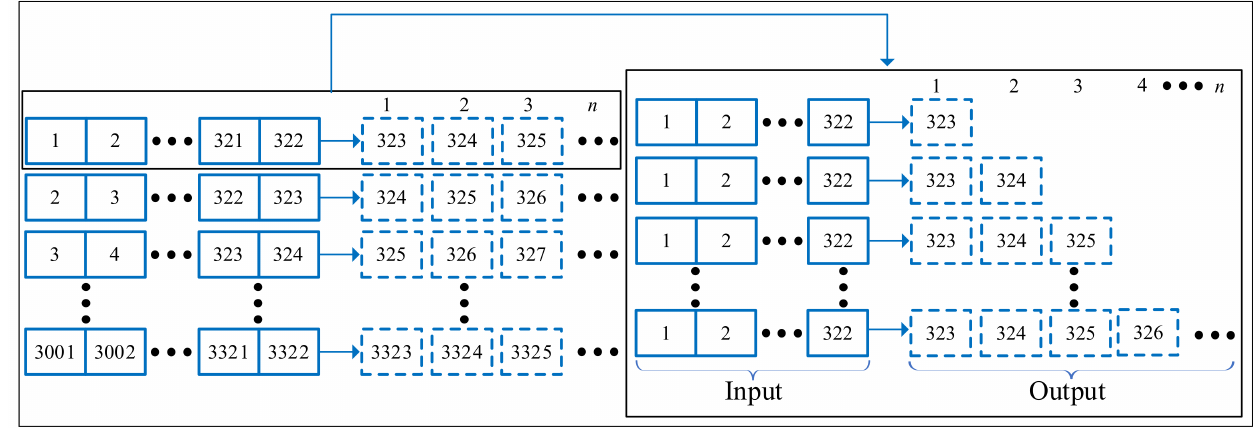
Figure 8. Input and output of the proposed